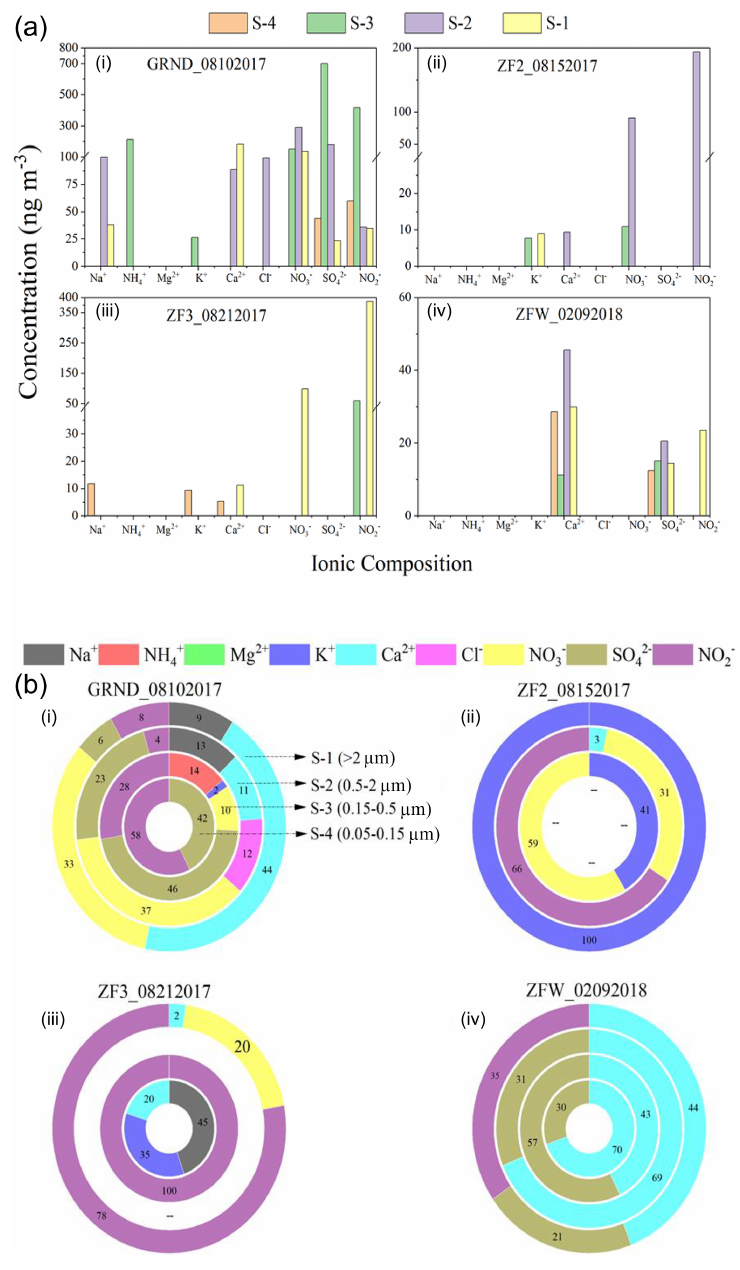
Figure 3. (a) Results from the analysis of inorganic aerosol for aerosol ionic composition of the filters collected (i) on the ground (ii) during ZF2, (iii) during ZF3 in summer 2017, and (iv) during ZFW in winter 2018. (b) The percentage distribution of individual ions. S-1 to S-4 indicate the four stages of the impactor. The size cutoffs are > 2, 0.5, 0.15, and 0.05 µm for S-1, S-2, S-3, and S-4,